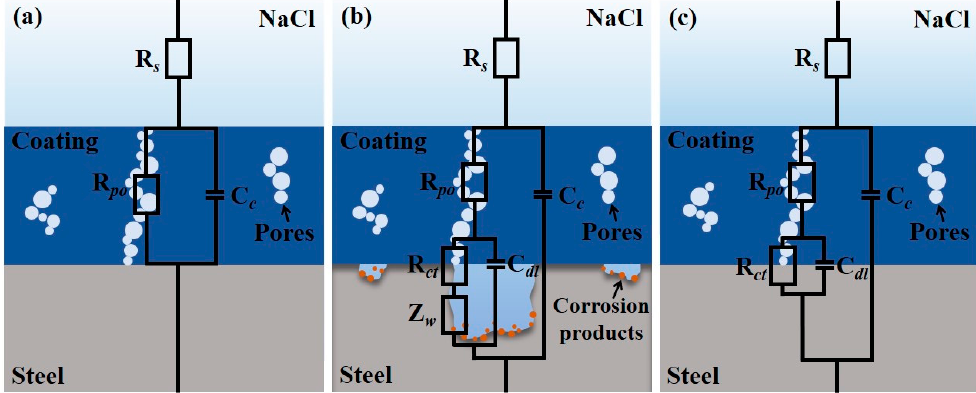
Figure 7. The equivalent electric circuits of ( a ) all of coatings immersion 1 day; ( b ) PI, ( c ) AT and EIO immersion 30 days.